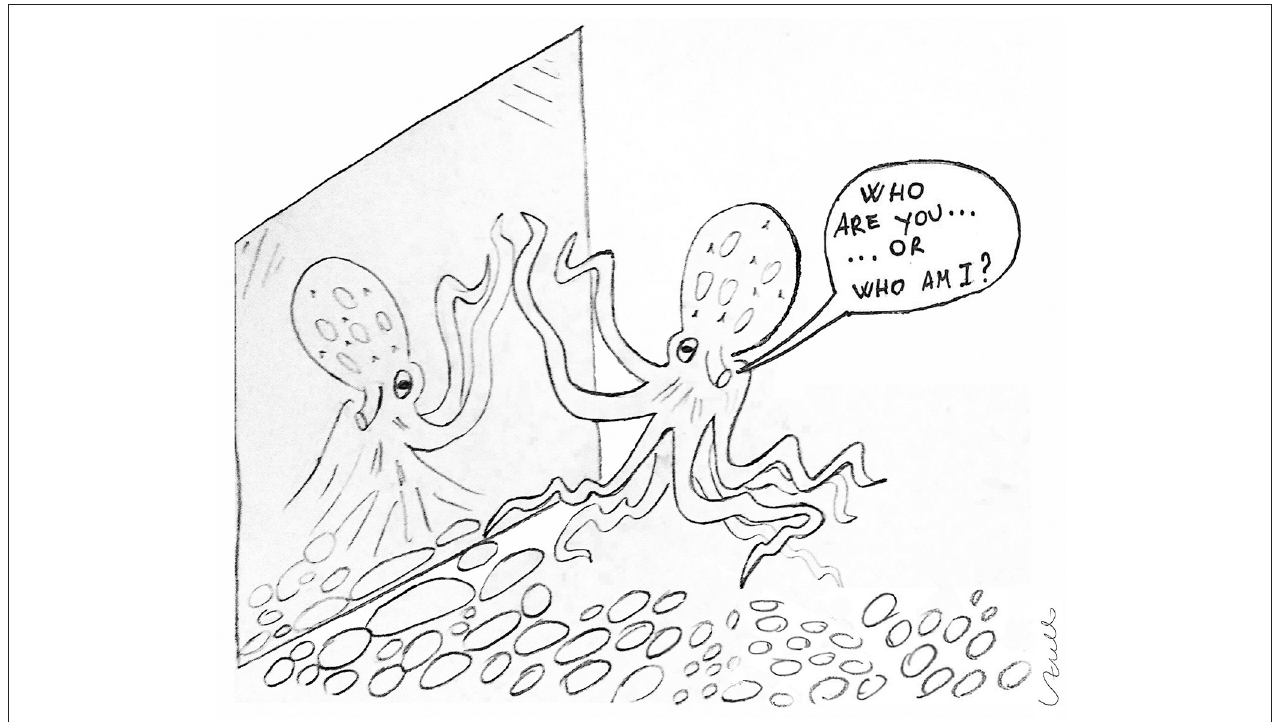
FIGURE 1 | What consciousness in Cephalopods? Sketch representing the Gallup’s mirror test technique applied to an octopus to assess its visual self-recognition abilities (drawing by L. Zullo).